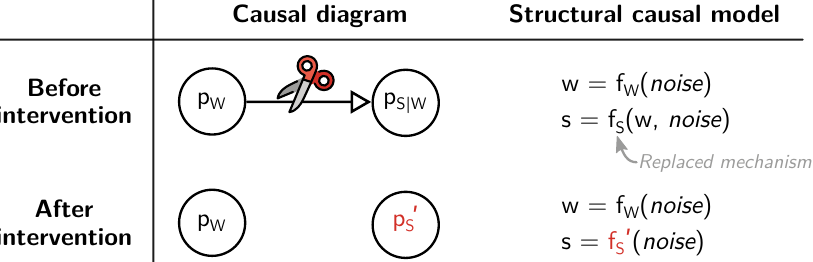
Figure 4. An intervention can be explained formally through its relation to structural causal models. Every conditional distribution with density p Y | X can be written in the form of a deterministic mechanism f Y , of which is a function of the values of the parents X and an independent noise part. The joint distribution of a set of variables is thus given as a structural causal model by the set of mechanisms and noise distributions. An intervention in this formalism consists of replacing a mechanism. In the exemplified case—cutting a microphone cable—the dependency on the parent is removed, resulting in a mechanism independent of the W . The principle of an independent causal mechanism refers to the fact that W and S are statistically dependent, while their mechanisms f W and f S can be independently